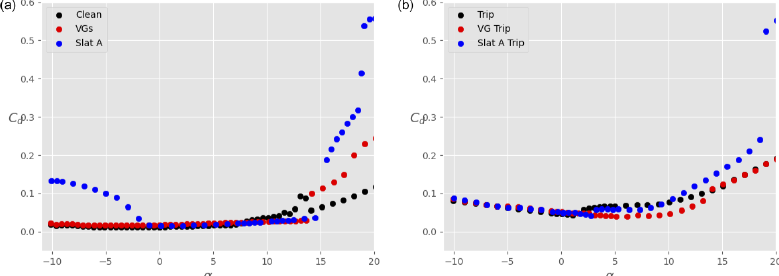
Figure 18. Drag coefficient C d as a function of the angle of attack α for the main airfoil at Re = 1 . 5 × 10 6 , without VGs and without slat (black), with VGs only (red), and with slat only in configuration A (blue). (a) Clean airfoil; (b) tripped airfoil.